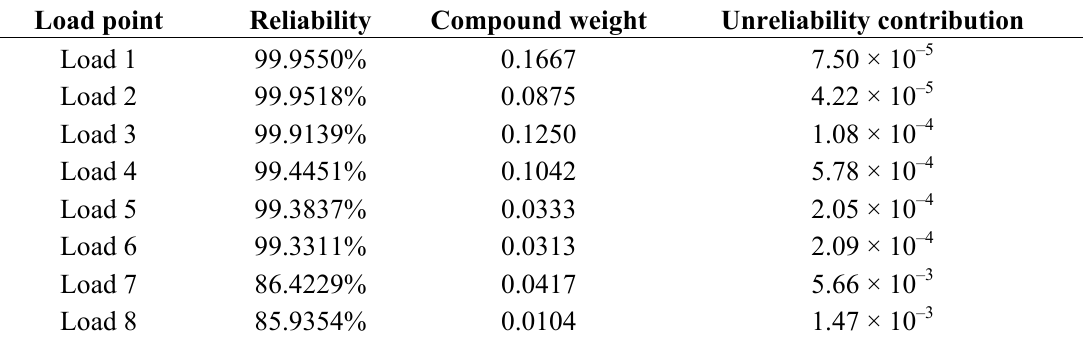
Table 3. Assessment results in a year for load points in the local